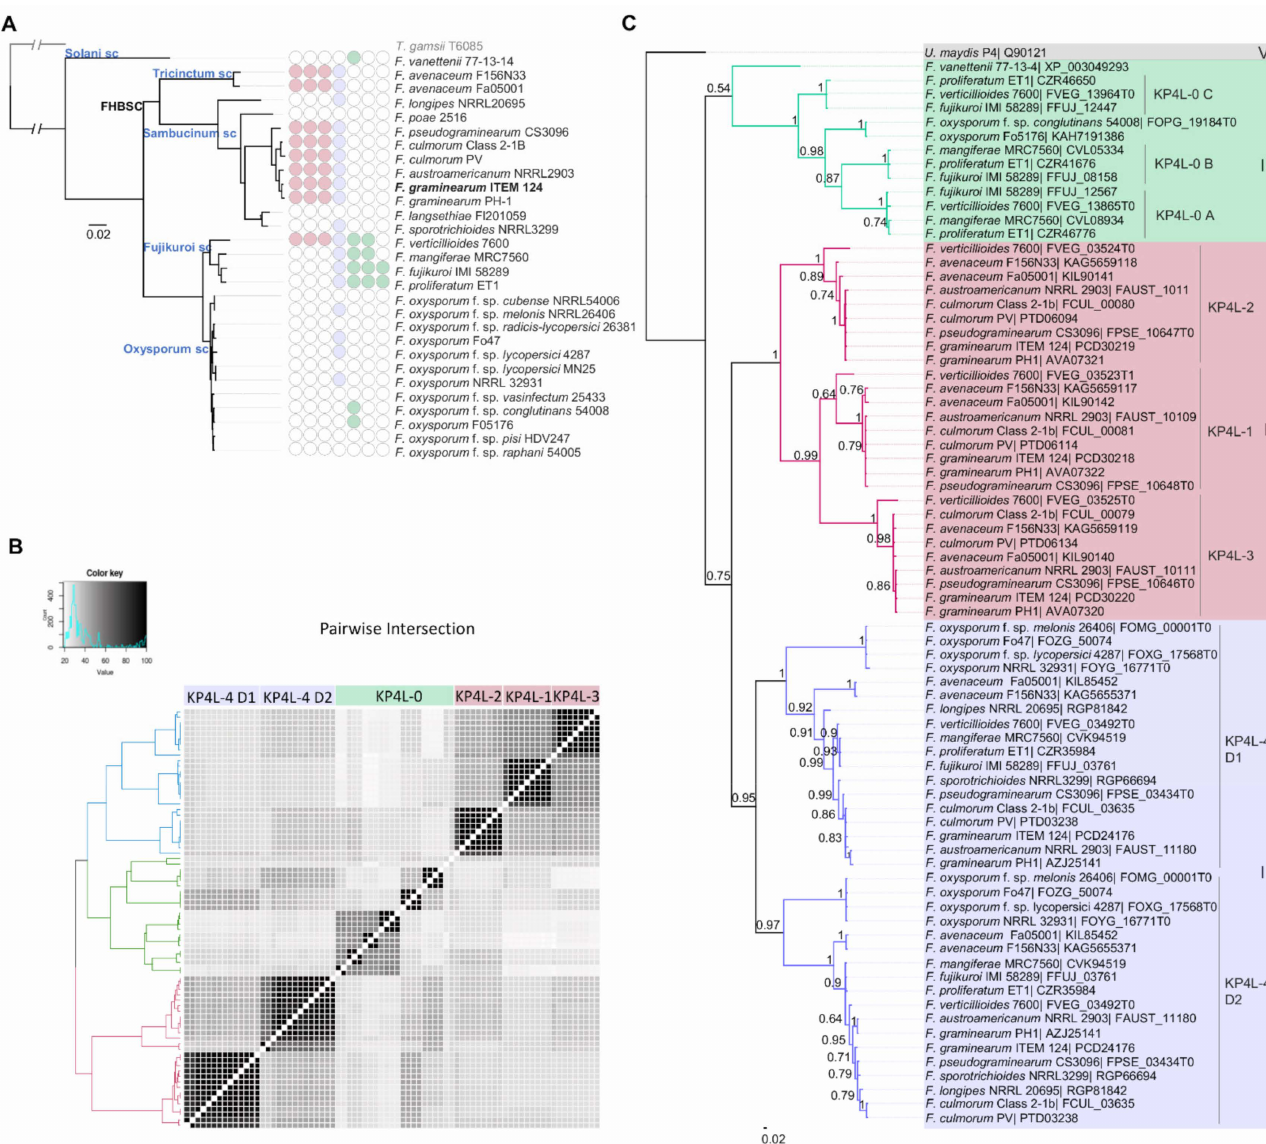
Figure 4. Distribution and phylogenetic relationships of KP4L proteins in the genus Fusarium . ( A ) Phylogenetic relationships of Fusarium spp. species were included into different species complexes according to the taxonomy described by O’Donnell et al. [38] and Summerell [1]. All nodes were supported by bootstrap values of 100%. The KP4L-gene content per each species is shown in colored dots on the branches of the tree of each species: Group I (pink color) including KP4L-1, -2 and -3, Group II (blue color) including KP4L4, Group III (green color) including KP4L-0 A, B and C, and Group VI (grey color) including the U. maydis KP4. ( B ) A pairwise intersection heat map of KP4L proteins was calculated using Intervene (University of Oslo, Oslo, Norway) [56]. ( C ) Phylogenetic characterization of Fusarium spp. KP4L proteins. Proteins were classified according to the groups as described by Lu and Faris [20]: Group I (pink color), Group II (blue color), Group III (green color) and Group VI (grey